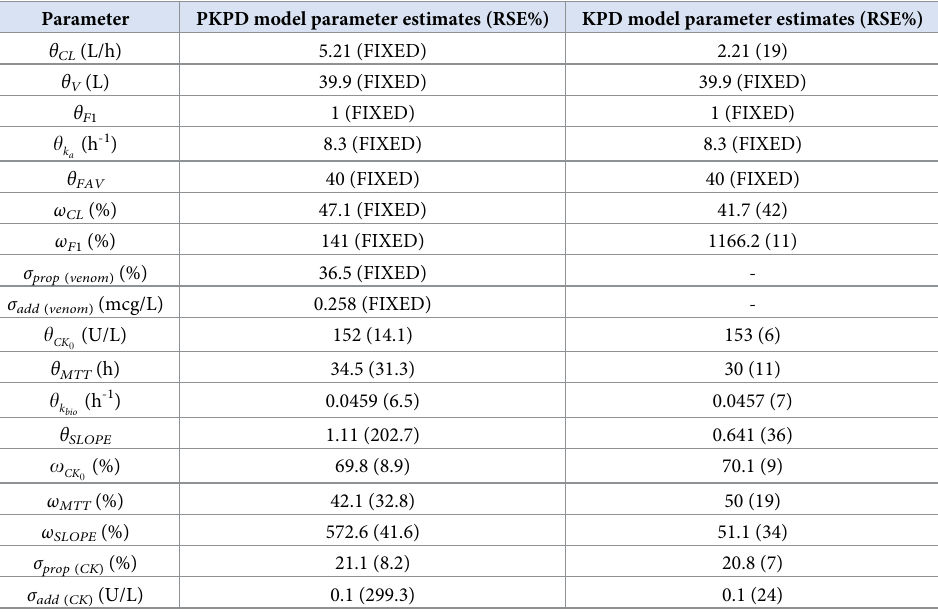
Table 3. Final pharmacokinetic-pharmacodynamic model and kinetic-pharmacodynamic model parameter esti- mates. Linear linker model was used here to describe the concentration-effect relationship.